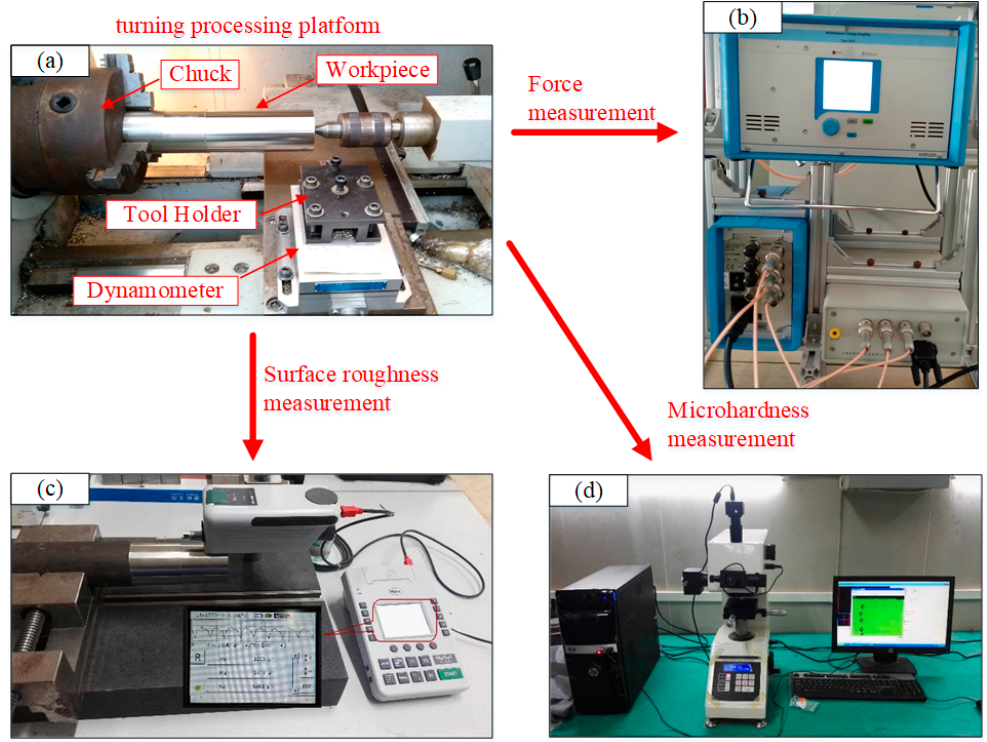
Figure 3. Cutting test measurement system: ( a ) turning processing platform; ( b ) cutting force measurement platform; ( c ) surface roughness measurement platform; ( d ) microhardness measurement platform.